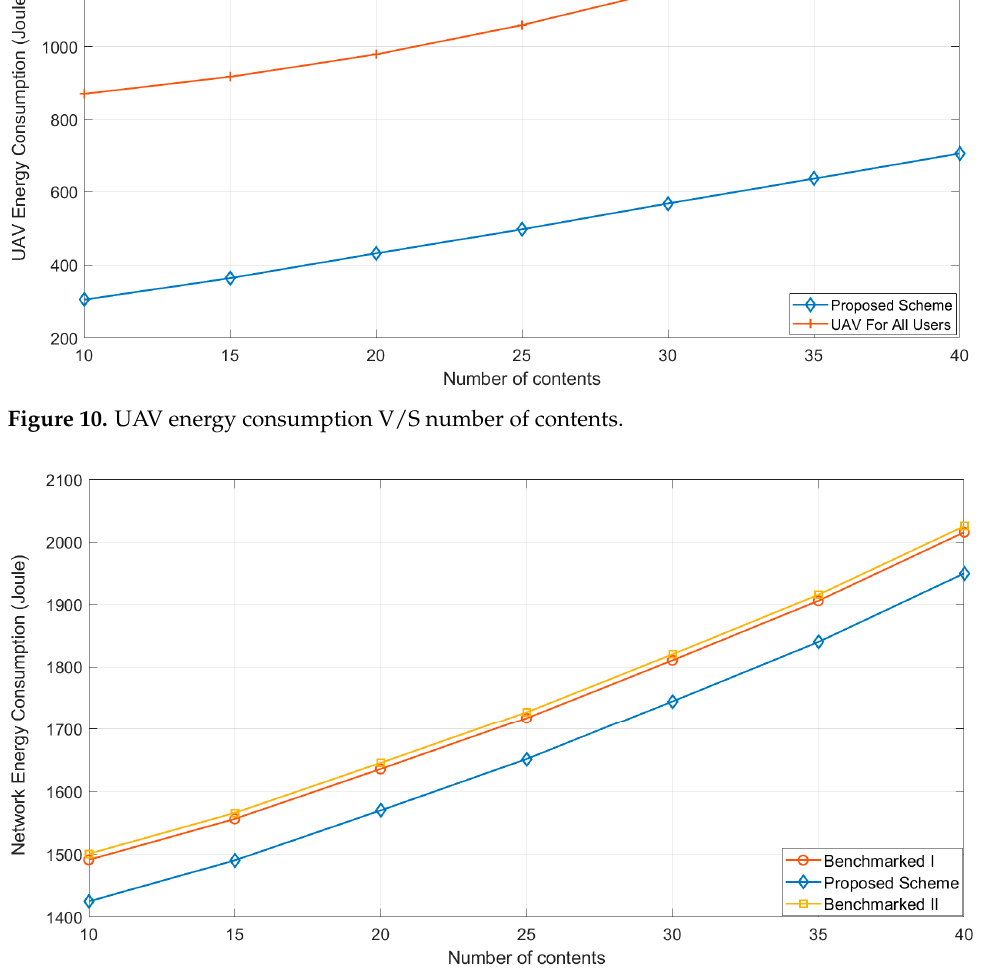
Figure 11. Network energy consumption V/S number of contents.